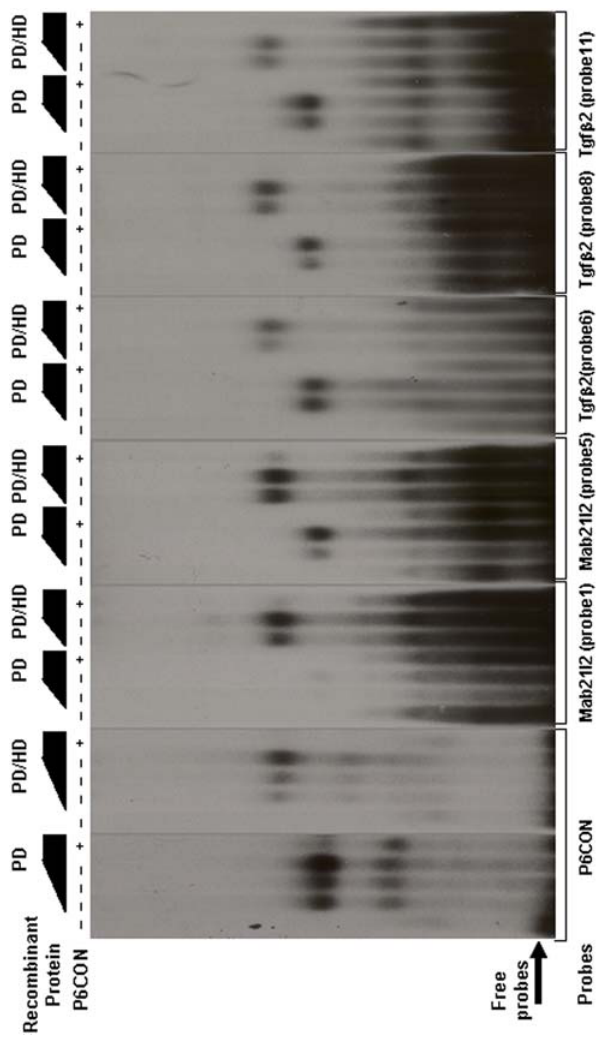
Figure 7. EMSAs with five Pax6-binding sites confirmed by qChIP in Mab21l2 and Tgfb2 loci. P6CON, Mab21l2 (sites 1 and 5), and Tgfb2 (site 6, 8 and 11/12) formed specific complexes with recombinant Pax6 GST-PD and GST-PD/HD proteins. The individual autoradiograms were exposed for 2.5, 15, 15, 10, 21 and 10 hours, respectively. 50 ng (approximately 50:1 molar ratio with the radioactive probe) P6CON ds oligonucleotide competitor was added as indicated to demonstrate specificity of individual